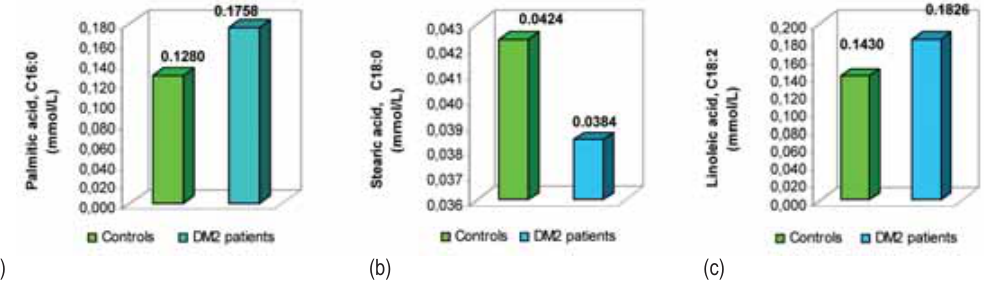
FIGURE 2. Average concentration of palmitic acid (a), stearic acid (b), linoleic acid (c) in plasma of male patients with Type 2 dibetes mellitus and control subjects, no statistically signi fi cant.